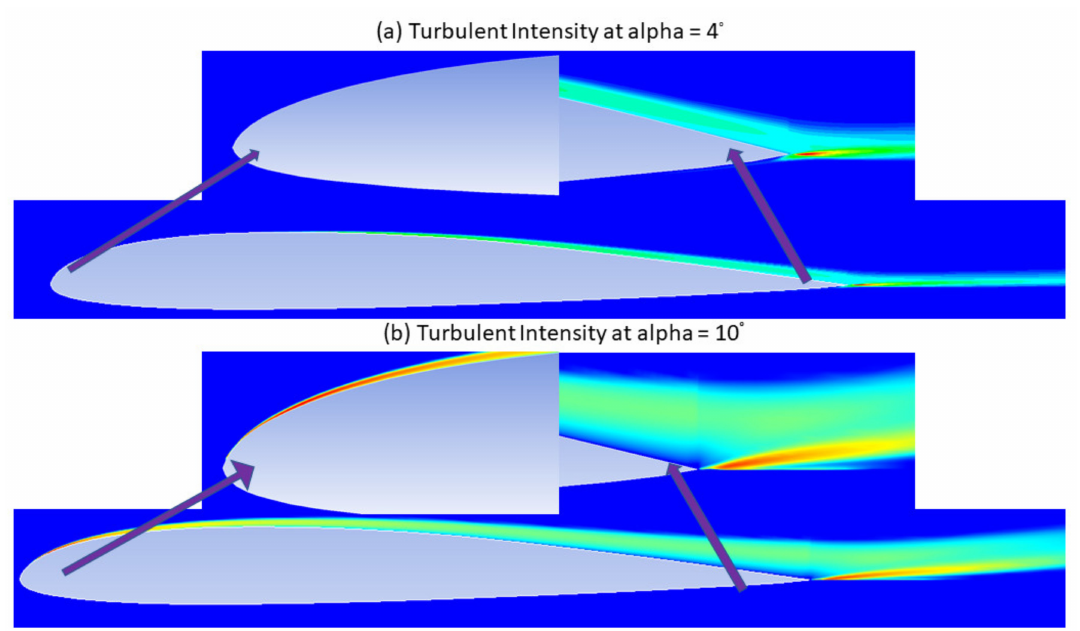
Figure 11. Contour plots of turbulent intensity comparison for baseline airfoil at the airspeed of 34 m/s. ( a ) the turbulent intensity at a low angle of attack of 4 ◦ ; ( b ) the turbulent intensity at a low angle of attack of 10